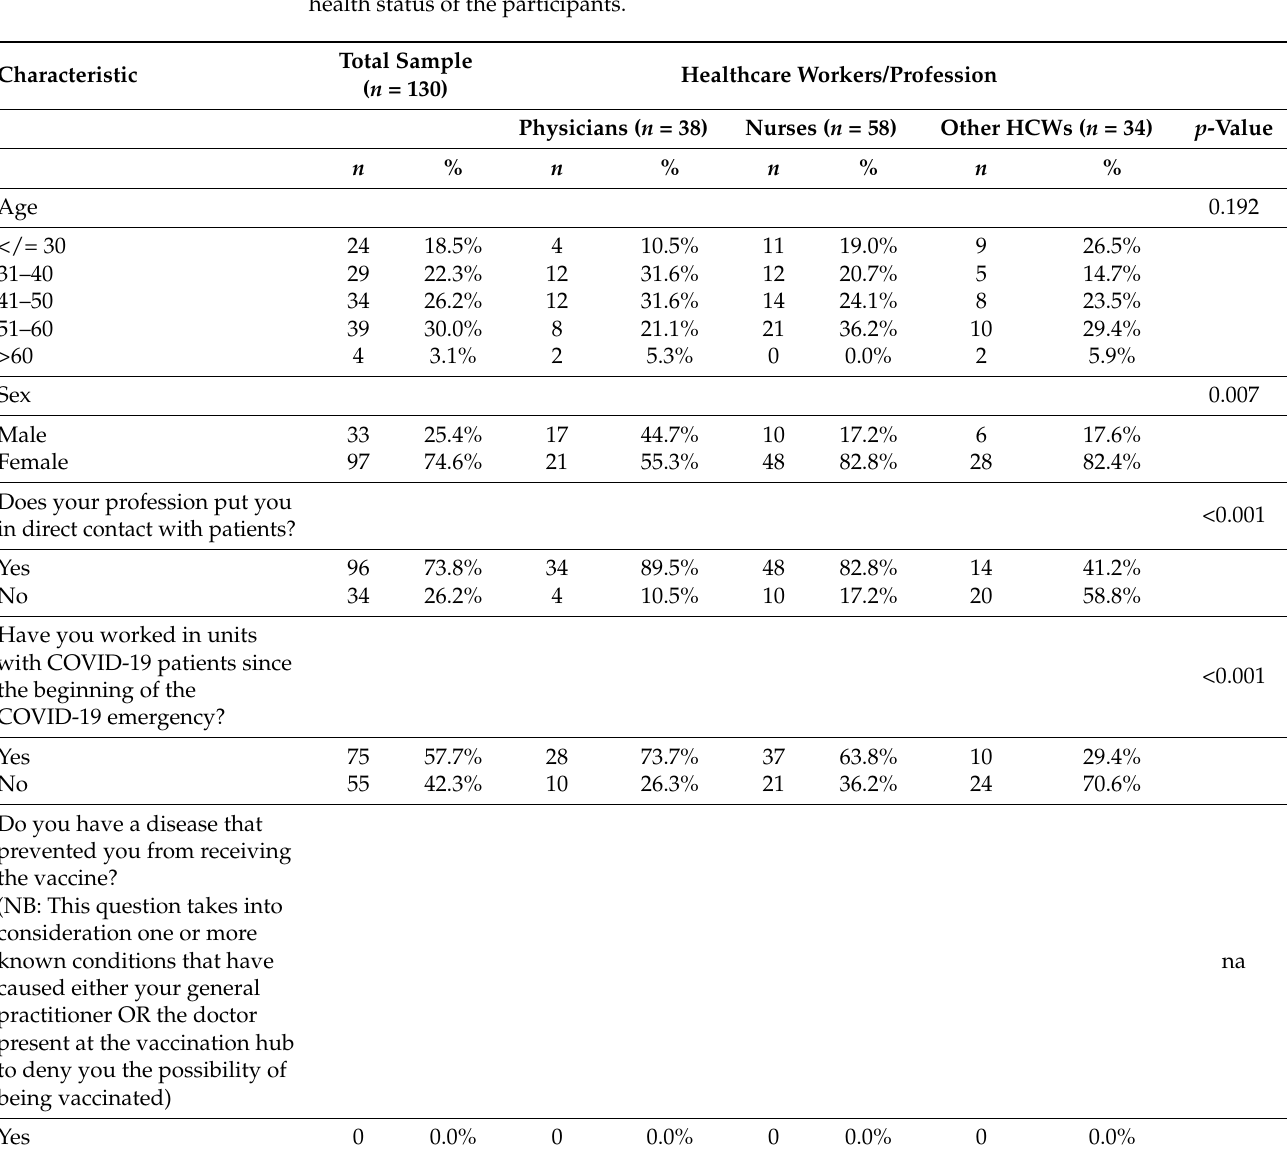
Table 1. Demographic data, professional profiles, work-environment-related risk of infection, and health status of the